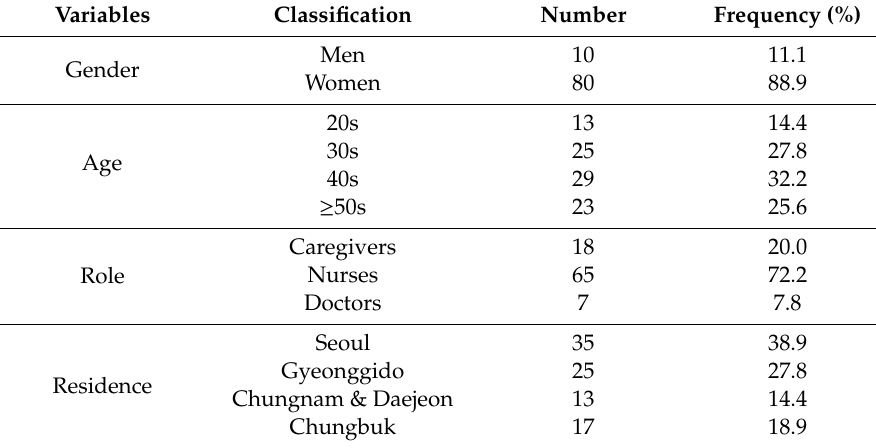
Table 2. Demographic